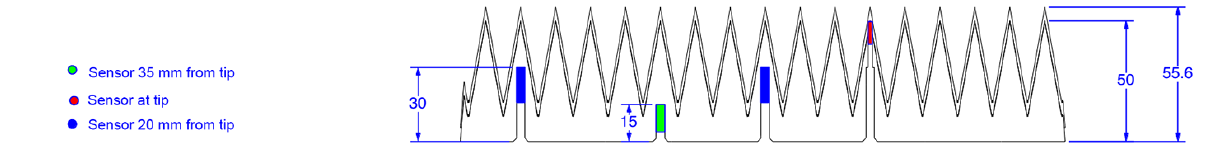
Figure 4. Cross section of internal calibration target showing locations of